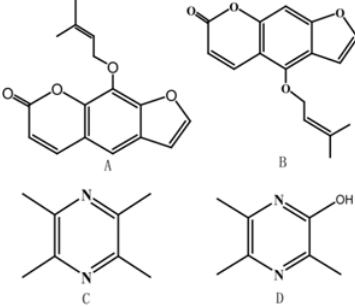
Figure 1. Chemical structures of imperatorin ( A ), isoimperatorin ( B ), ligustrazine ( C ) and hydroxy‐ligustrazine ( D ).